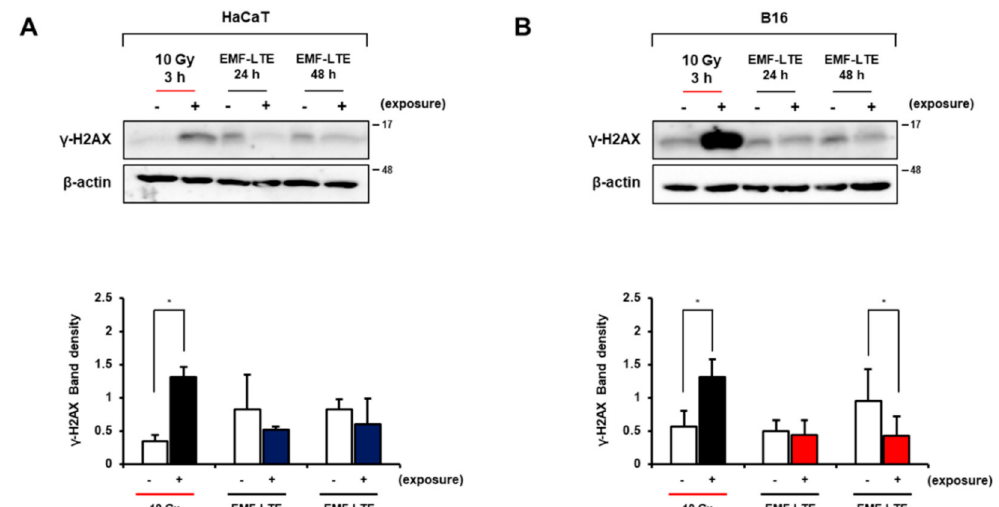
Figure 4. Effects of EMF-LTE on DNA DSB damage markers in HaCaT and B16 cells. The representative blotting images of γ -H2AX protein in ( A ) HaCaT and ( B ) B16 cells are presented (upper panel). Band density values were normalized to that of β -actin (lower panel). Graphs represent the mean ± SD of three independent experiments ( * p < 0.05 vs. corresponding control, paired sample t -test).